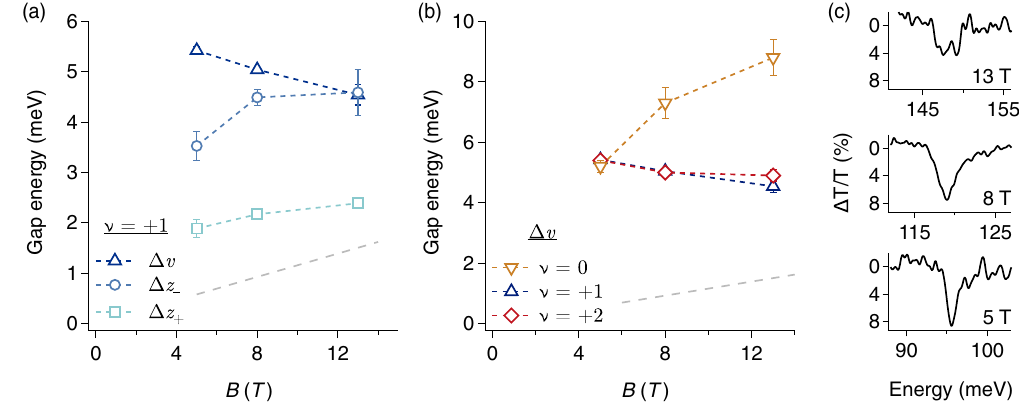
FIG. 3. Evolution of splittings with magnetic field. (a) Magnetic-field dependence of the observed gaps at ν ¼ 1 . The valley gap Δ v appears to decrease with increasing field, while the spin gaps Δ z − and Δ z increase with increasing field. All splittings observed are þ significantly larger than the bare Zeeman energy shown as a gray dashed line. (b) Comparison of the valley gaps calculated at integer filling as a function of magnetic field. (c) T 1 resonance at ν ¼ 0 for three magnetic fields. With increasing field, the resonance broadens and shows an incipient